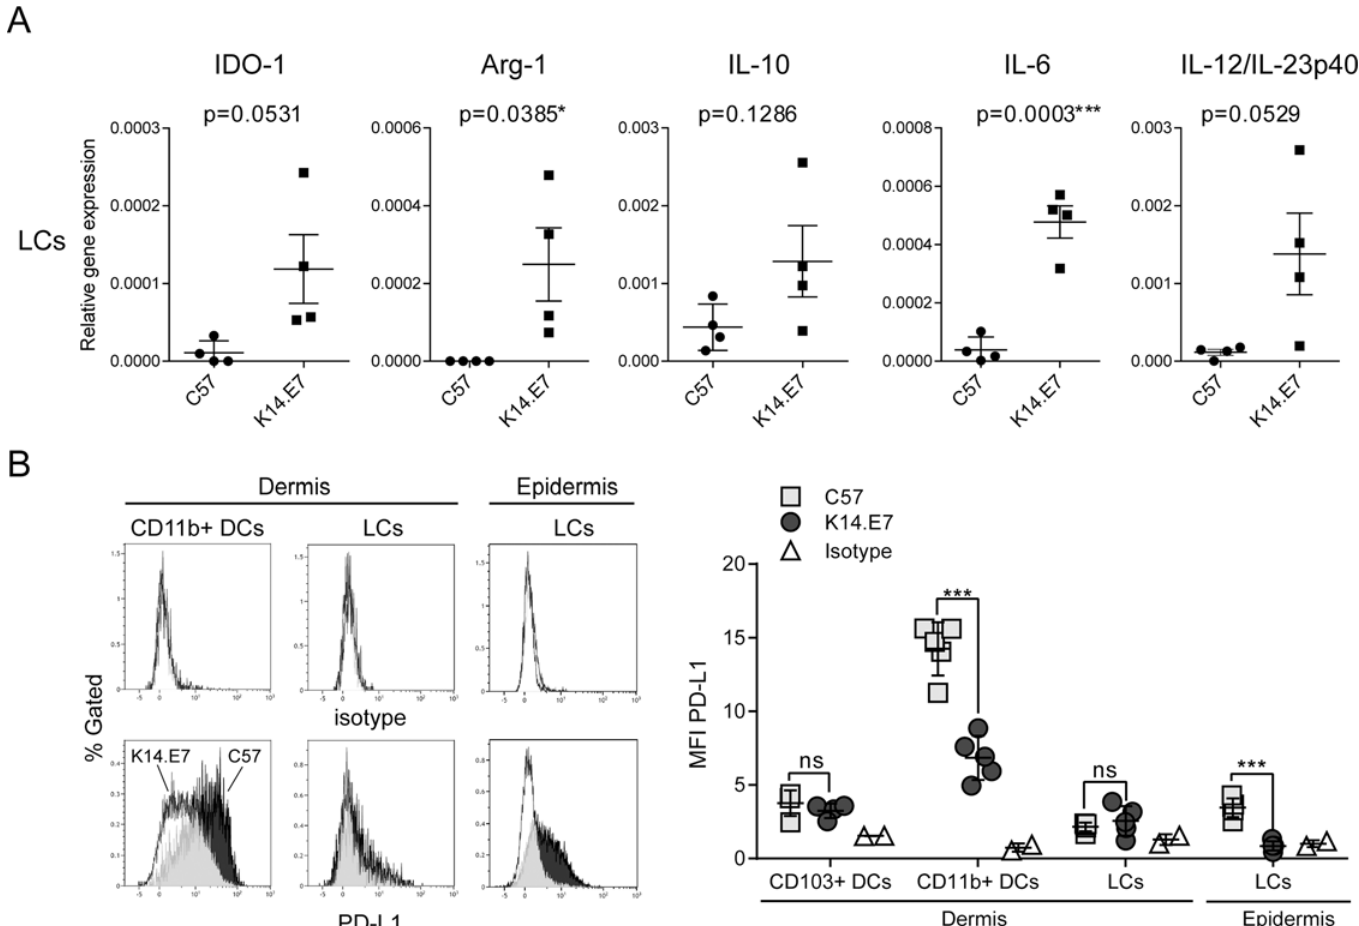
Fig 3. Epidermal LCs of K14.E7 mice express immune-modulatory cytokines and enzymes. (A) Single cell suspensions of C57BL/6 and K14.E7 epidermis were prepared. LCs (singlets, live CD45 + CD11c + MHCII + CD11b + Epcam + CD103 - ) of K14.E7 and C57BL/6 epidermis were sorted with purity above 96%. Relative gene expression of IDO-1, Arg-1, IL-10, IL-6 and IL12/23p40 messenger RNA was determined by real-time qPCR and normalized against housekeeping gene RPL32. Data are presented as means ± SEM of four independent experiments in which ear epidermis of either 4 C57BL/6 or 2 K14.E7 mice was pooled prior to LC isolation. (B) Single cell suspensions of C57BL/6 and K14.E7 dermis and epidermis were analyzed for the expression of PD-L1 on different CD45+ antigen presenting cell subsets. Gating strategy to identify LCs, CD11b + and CD103 + DCs in C57BL/6 and K14.E7 skin was performed as shown in Fig 1A and Fig 2A. Expression of cell surface PD-L1 on dermal and epidermal DCs was analyzed. Representative histograms (C57 = black, K14.E7 = white) of CD11b+ DCs, LCs and matching isotype controls, and pooled median fluorescent intensity MFI data (n = 5) are